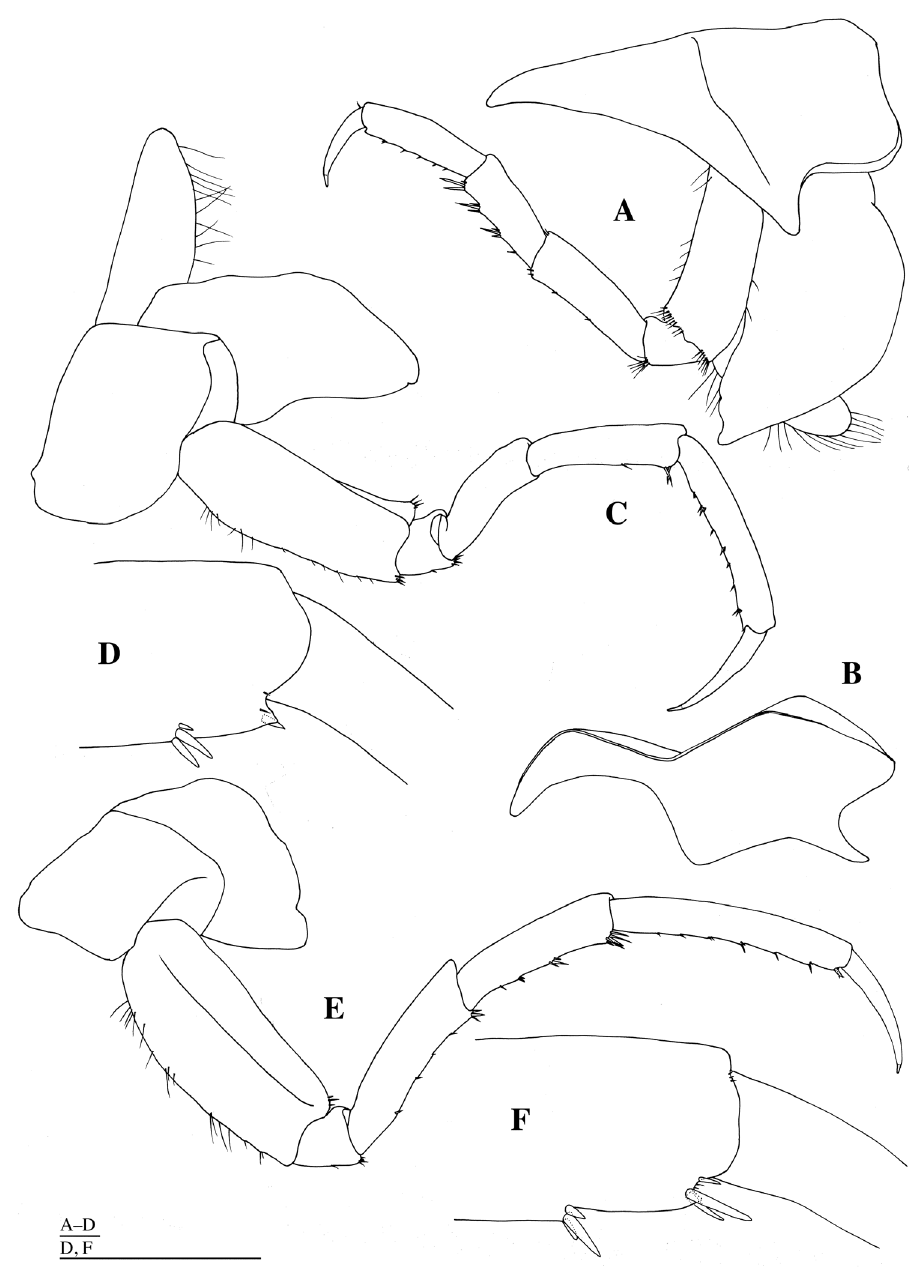
Figure 7. Epimeria abyssalis sp. n., holotype female: A left pereopod 4, lateral B coxa of left pereopod 4, dorsal C left pereopod 5, lateral D distal part of propodus of left pereopod 5, lateral E left pereopod 6, lateral F distal part of propodus of left pereopod 6, lateral. Scale bars: 1